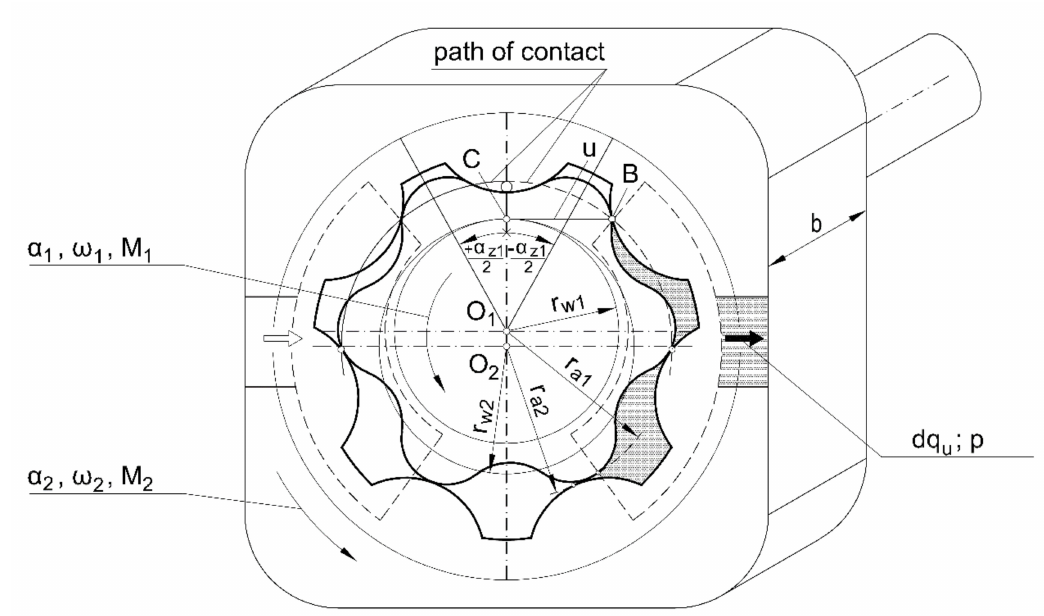
Figure 9. Model of a gerotor machine with epicycloidal